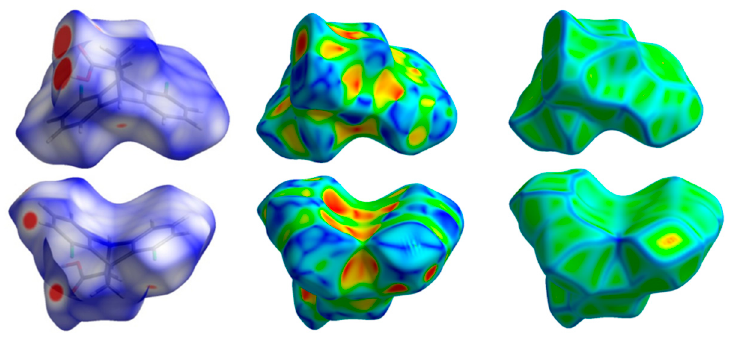
Figure 3. Hirshfeld surfaces of 5 .